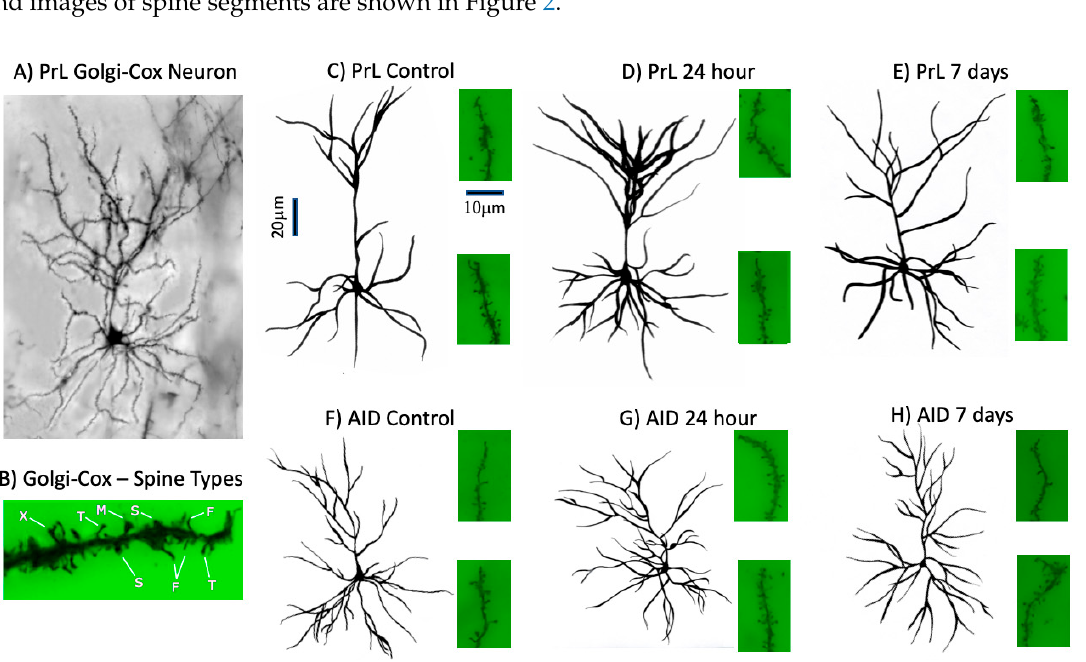
Figure 2. Representative Golgi–Cox staining of a layer II/III PrL neuron ( A ) and terminal spine segment ( B ), illustrating the quality of the staining. Example spine types (T = thin, S = Stubby, M = Mushroom, F = Filopodial, X = multi-headed) are shown in B. Representative camera lucida drawings of layer II/III neurons and images of spine segments from the apical and basilar fields are shown in ( C )–( D ) (PrL) and ( F )–( G ) (AID). The vertical scale bar (20 μ m) provides scale for neurons in panels ( A ) and ( C )–( H ). The horizontal scale bar (10 μ m) provides scale for spine segments in panels ( C )– ( H ).